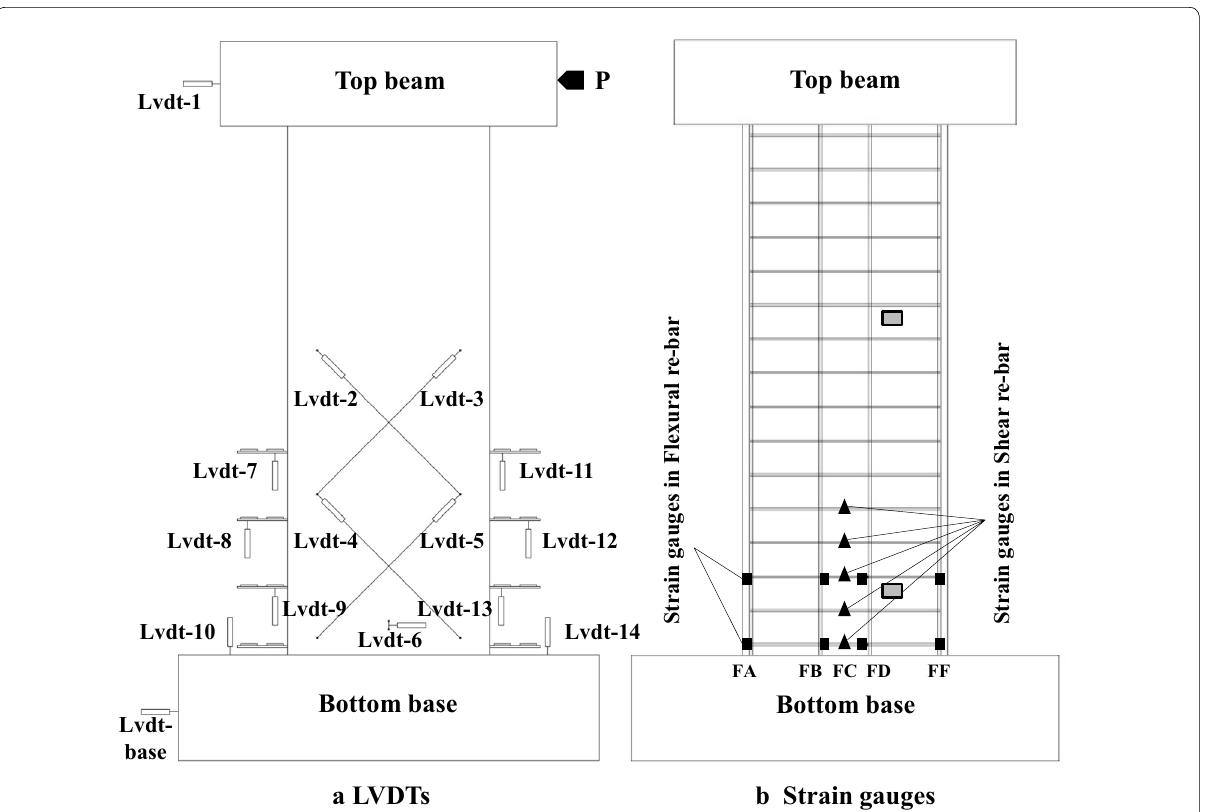
Fig. 7 LVDTs and strain